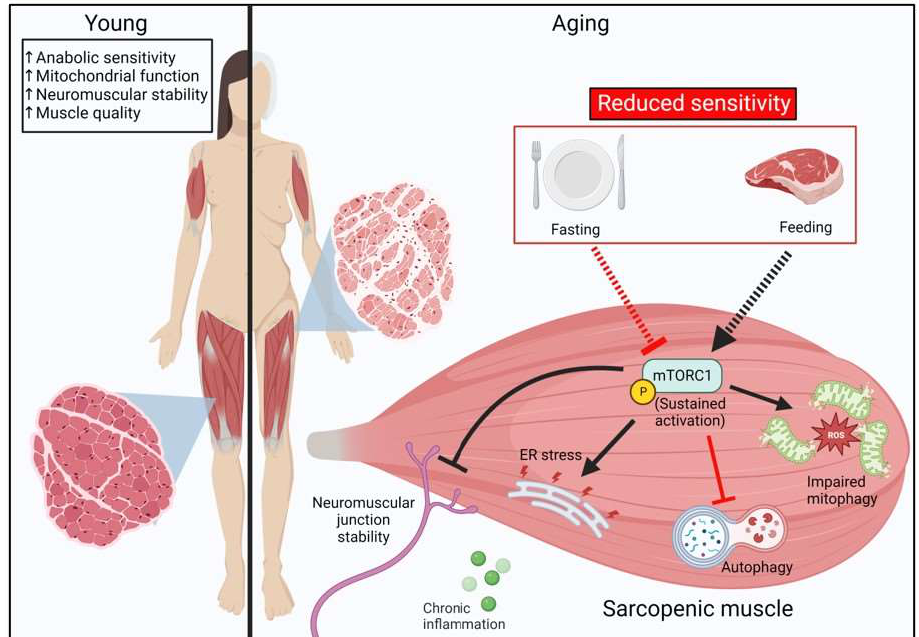
Figure 2. Proposed model of mTORC1-mediated muscle atrophy in sarcopenia. Aged skeletal muscle exhibits anabolic resistance to hyperaminoacidemia characterized by an impaired protein synthetic response. Basal mTORC1 exhibits sustained activation in aged skeletal muscle, that can contribute to neuromuscular junction instability, ER stress, and impaired mitophagy. Poor cellular quality control mechanisms result in a compromised mitochondrial pool, leading to impaired bio- energetics and enhanced reactive oxygen species production.